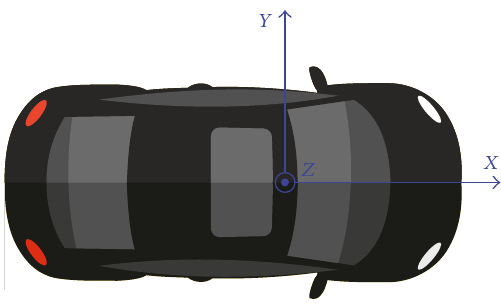
Figure 4: Reference system of the ego vehicle.